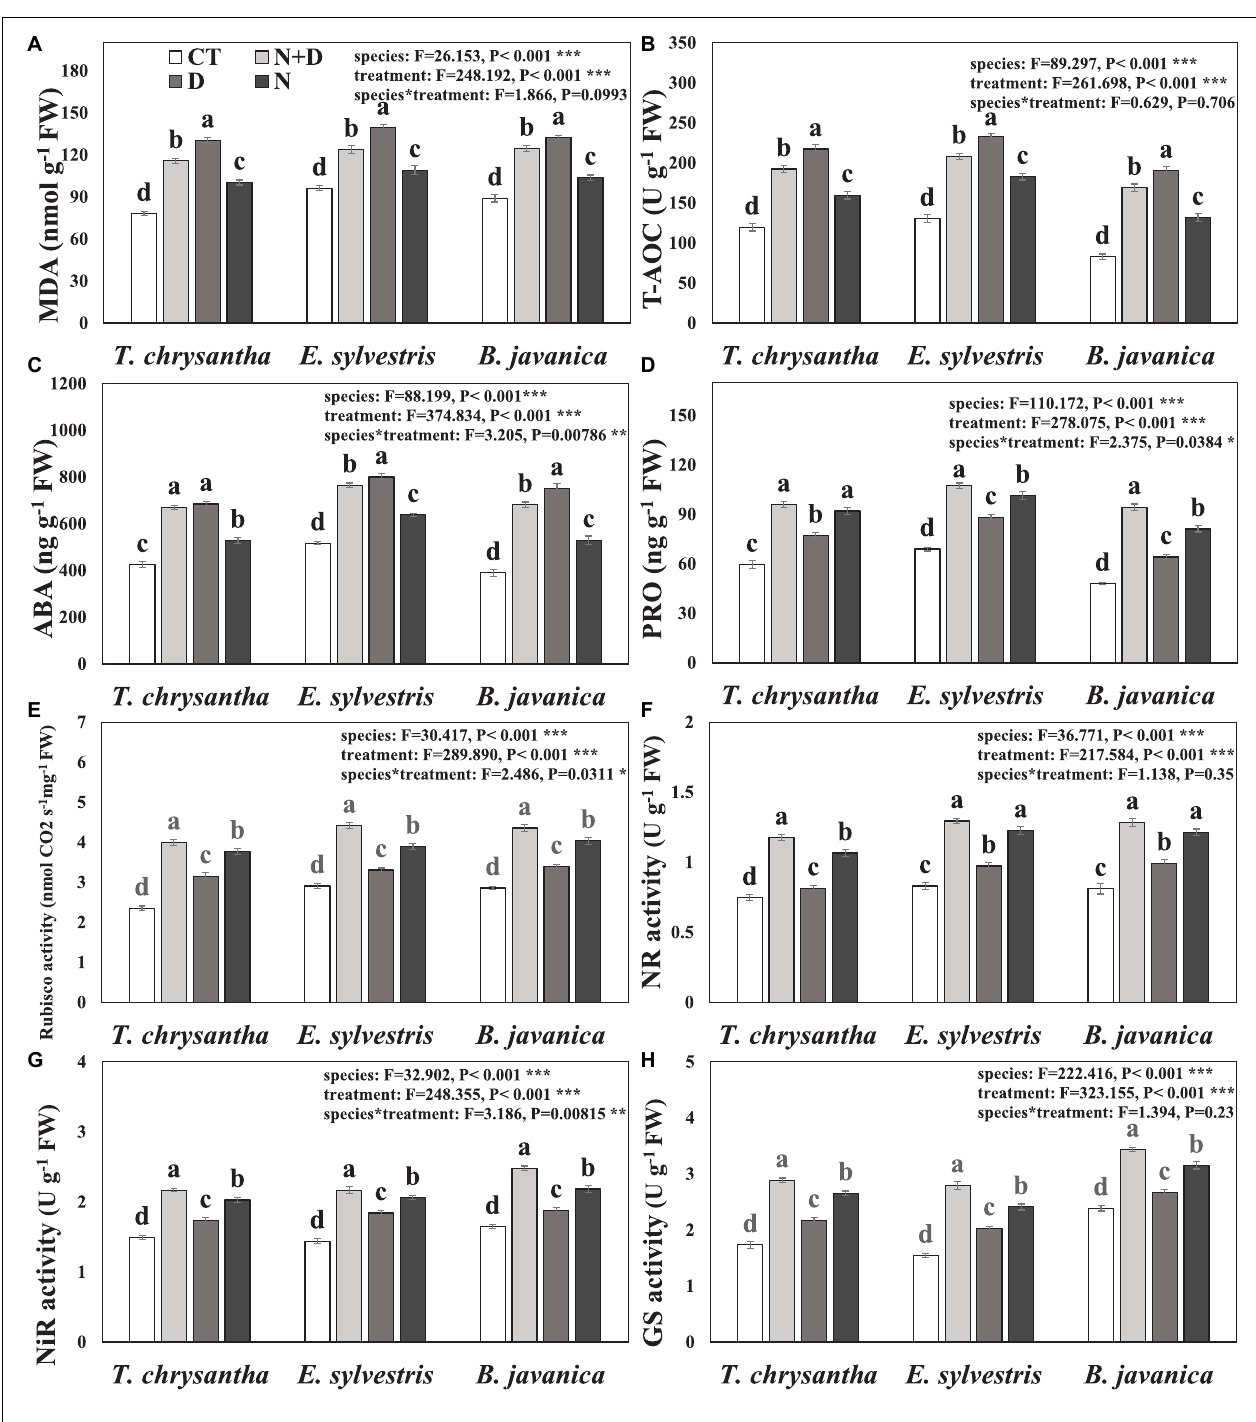
FIGURE 1 | Malondialdehyde (MDA) concentration (A) , total antioxidant capacity (T-AOC) (B) , abscisic acid (ABA) concentration (C) , proline (PRO) concentration (D) , ribulose-1, 5-bisphosphate carboxylase/oxygenase (Rubisco) activity (E) , nitrate reductase (NR) activity (F) , nitrite reductase (NiR) activity (G) , and glutamine synthetase (GS) activity (H) of Tabebuia chrysantha , Elaeocarpus sylvestris , and Bischofia javanica in response to control (CT), nitrogen addition plus drought(N+D), drought (D), and nitrogen addition (N) treatments. Different letters indicated the significant difference by Fisher’s least significant difference (LSD) test ( P < 0.05). Error bars were represented standard error